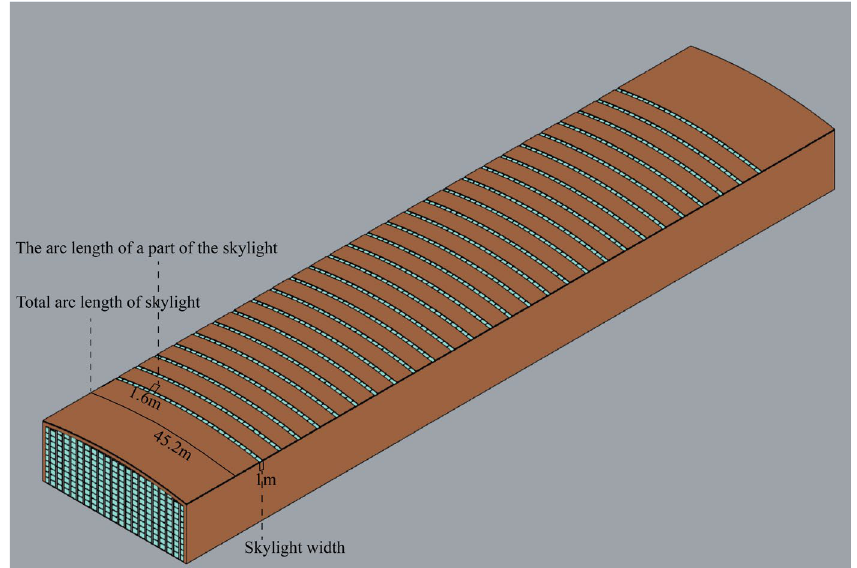
Figure 3. Parametric model of waiting hall of Harbin West Station.